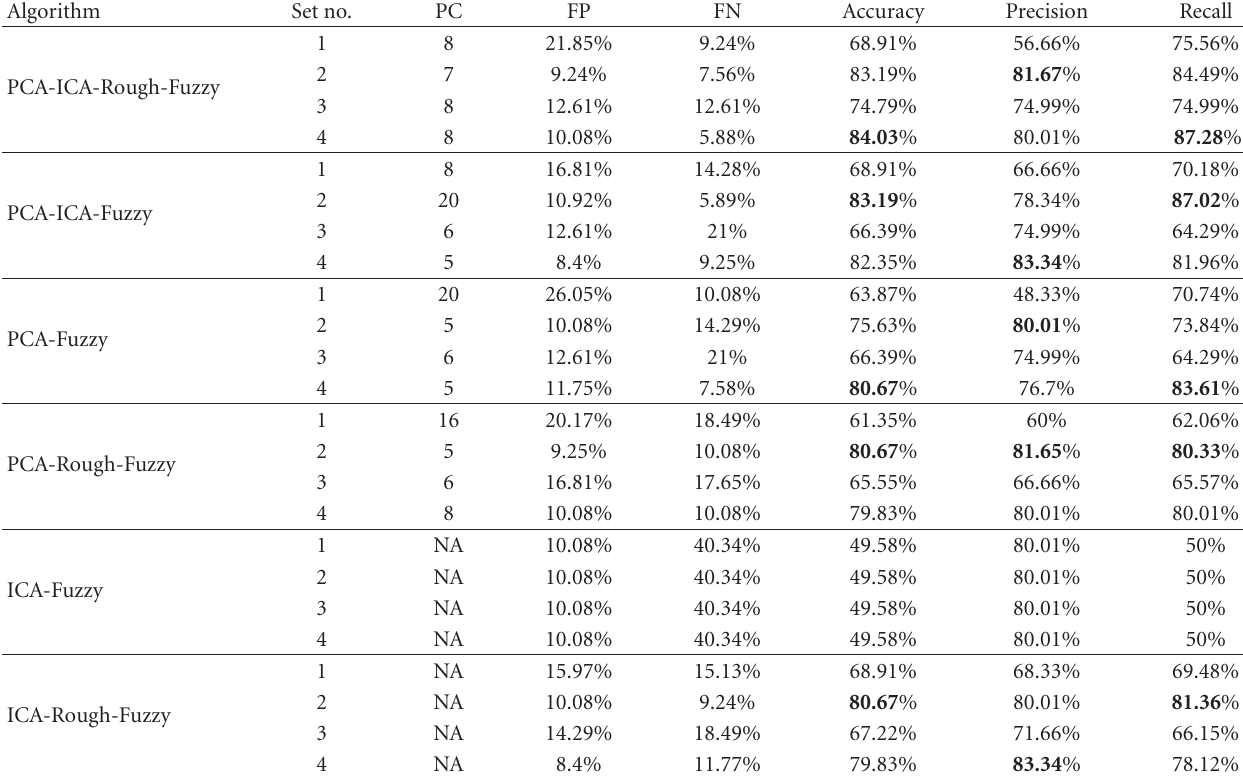
Table 3: Results of PCA-ICA-Fuzzy, PCA-ICA-Rough-Fuzzy, PCA-Fuzzy, PCA-Rough-Fuzzy, ICA-Fuzzy, and ICA-Rough-Fuzzy algorithms. NA: not applicable.